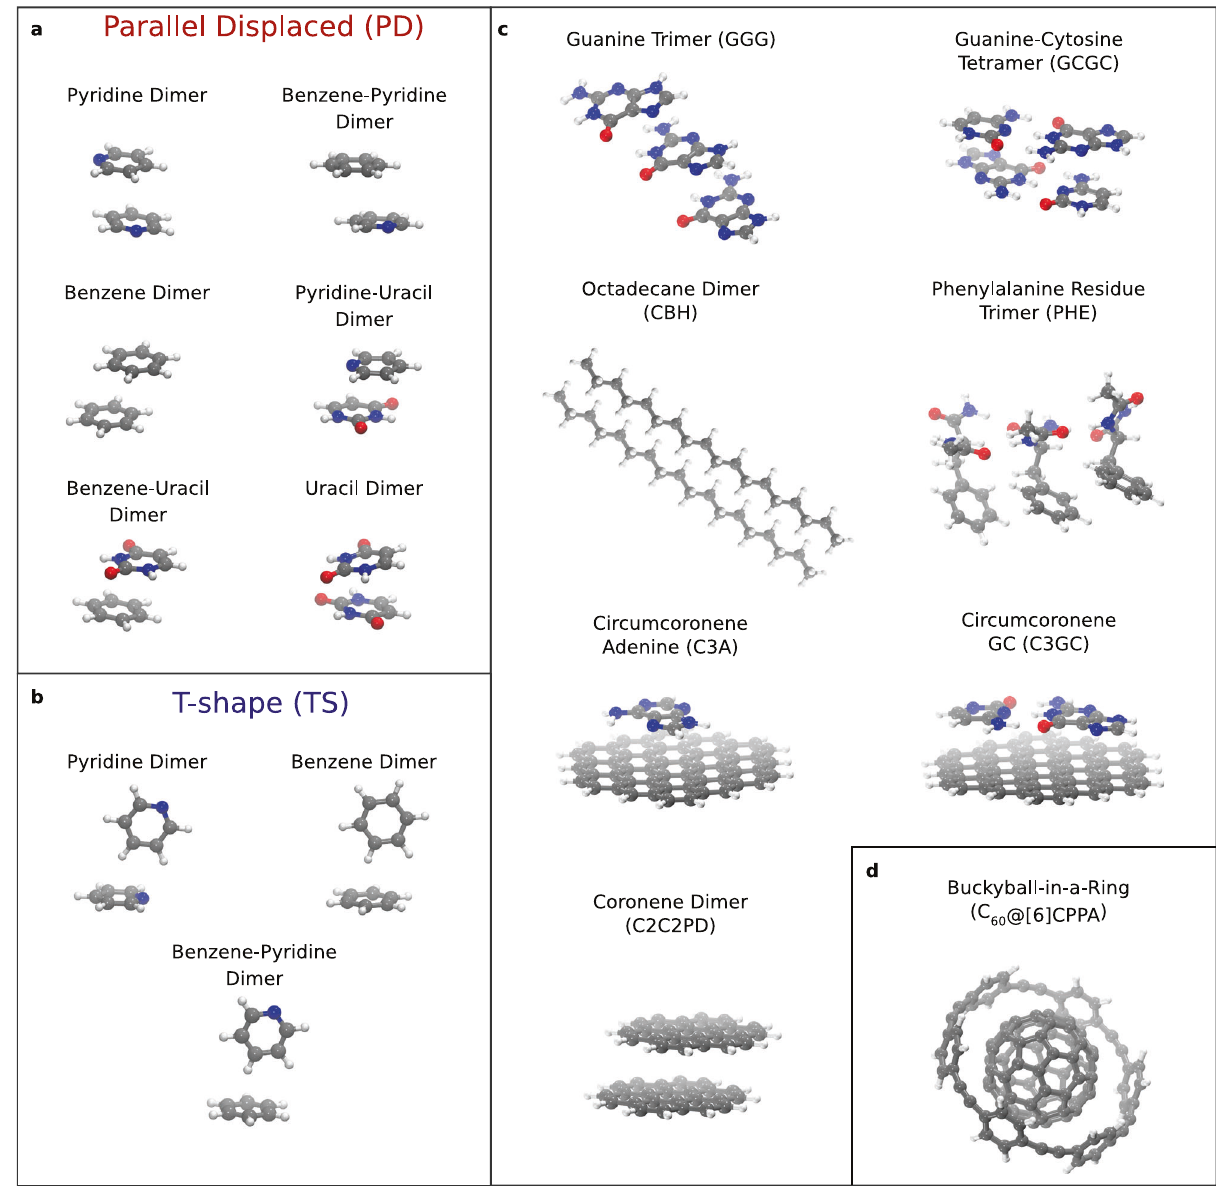
Fig. 2 Molecular complexes computed in this work. a Parallel displaced (PD) dimers of benzene, pyridine, and uracil molecules from the S66 data set 27 . b T-shape (TS) dimers of pyridine and benzene from S66. c The supramolecular complexes from L7 data set 28 and ( d ) a buckyball-ring supramolecular complex consisting of 132